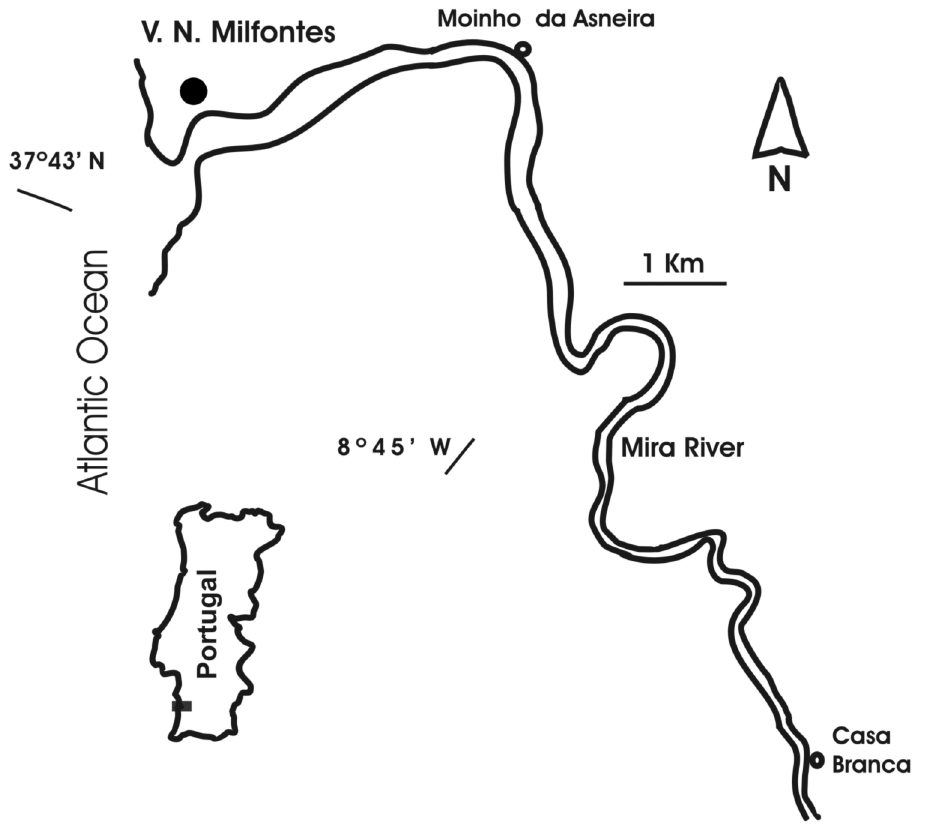
Fig. 2. Location map of Mira